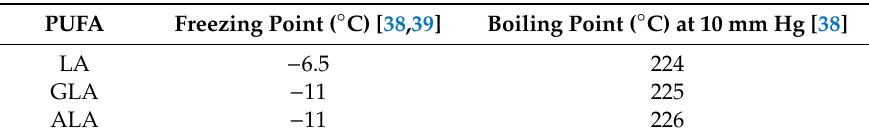
Table 4. Boiling and freezing points of LA, GLA, and ALA.